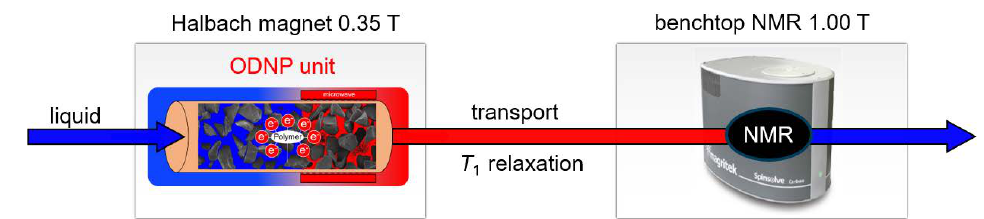
Figure 2. Scheme of the set-up for continuous-flow benchtop NMR measurements with ODNP unit. ODNP is performed at 0.35 T in a Halbach magnet. ODNP measurements are performed in two ways: (1) static ODNP with hyperpolarization directly in the Halbach magnet that is equipped with an ENDOR probehead for simultaneous microwave irradiation and NMR detection, and (2) continuous- flow ODNP, where hyperpolarization is accomplished in the Halbach magnet and NMR detection in the 1.00 T benchtop NMR spectrometer (transport distance is around 0.5 m). A HPLC pump is used to set up the liquid flow.